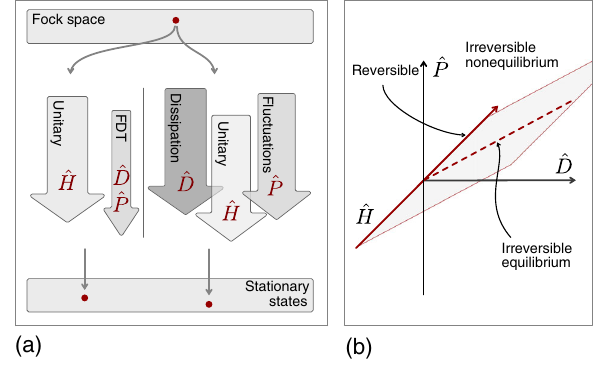
FIG. 1. Building blocks entering the description of state evolution of fermionic quantum matter. (a) The evolution of Fock space quantum states primarily depends on whether a system is in or out of equilibrium. In equilibrium, left, both the dynamics and the stationary state are controlled by a Hamiltonian ˆ H . [Thermalization at a given ambient temperature T may be effected by fluctuation and dissipation, subject to the fluctuation- dissipation theorem (FDT), Eq. (47).] Out of equilibrium, the ˆ H; ˆ D; ˆ P dynamics is specified in terms of three generators, , representing unitary evolution, dissipation, and fluctuations, respectively. In either case, initial Fock space states evolve into stationary states whose symmetries are determined by the dynamical generators, but not the initial configurations. (b) In equilibrium dynamics, fluctuation and dissipation are locked by the fluctuation-dissipation relation, Eq. (47), reducing the “ oper- ˆ H ˆ D ator space ” to two freedoms and controlling the relaxation into an equilibrium configuration. Antiunitary symmetries appear in combination with an inversion of time. The representation of antiunitary symmetries T depends on whether the dynamics is ˆ D ˆ P unitary ¼ ¼ 0 (T in combination with time reversal, t → − t ), irreversible equilibrium ˆ D ∝ ˆ P (T in combination with thermal time reversal, t → − t þ i β ), or irreversible out of equi- librium ( T in